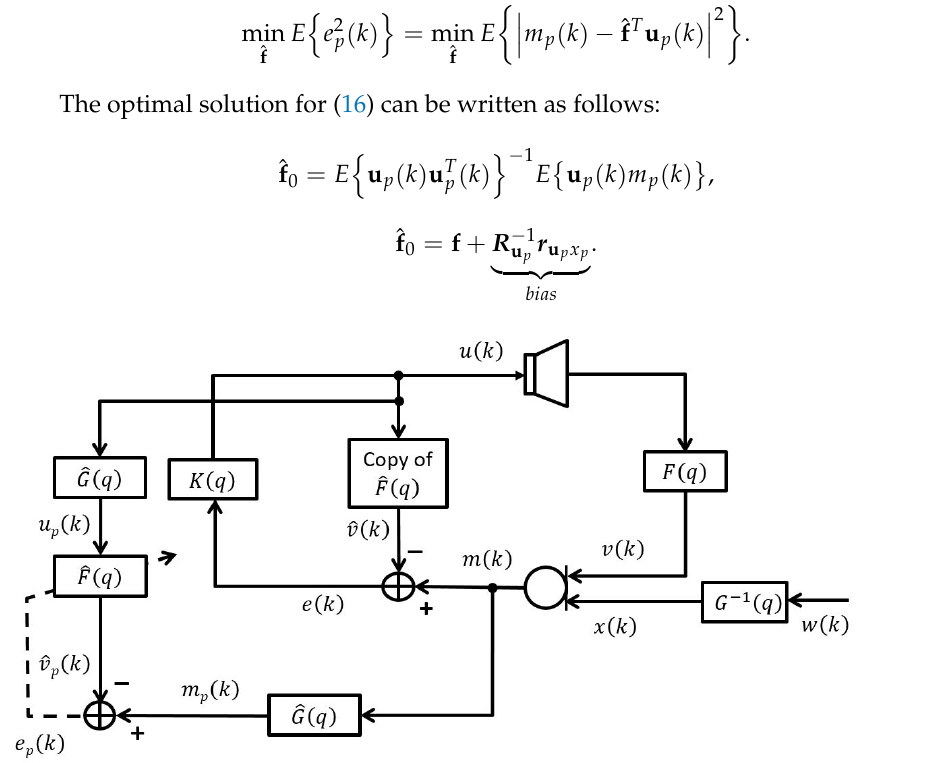
Figure 3. PEM-AFC